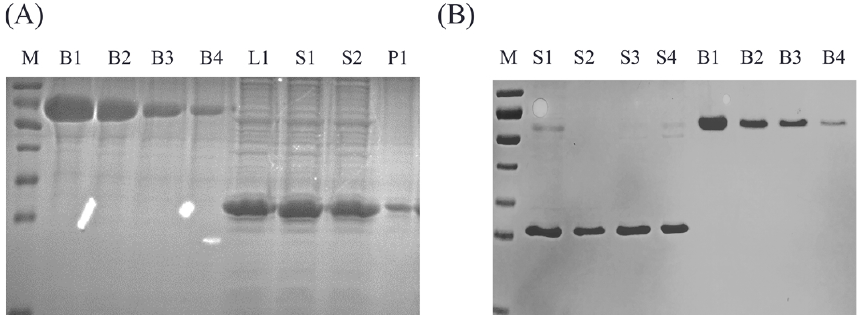
Figure 4. Application of the ELISA for quantification of samples. ( A ) The crude purified products and BSA protein were analyzed with SDS-PAGE. M, marker; B1, 1000 µ g/mL BSA; B2, 500 µ g/mL BSA; B3, 250 µ g/mL BSA; B4, 125 µ g/mL BSA; L1, total bacterial lysate; S1, supernatants; S2, supernatants; and P1, precipitation. ( B ) The final products and BSA protein were analyzed with SDS-PAGE. M, marker; four final product samples: B1, 500 µ g/mL BSA; B2, 250 µ g/mL BSA; B3, 125 µ g/mL BSA; and B4, 62.5 µ g/mL BSA. Table 3. The compliance rate of VLPs in cell lysates, supernatants, and precipitations. Sample